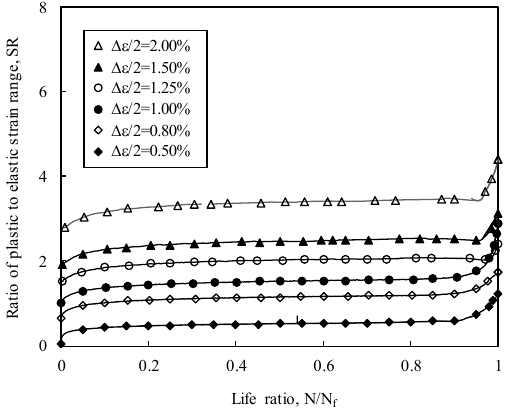
Figure 6. Ratio of plastic to elastic strain range versus life ratio.